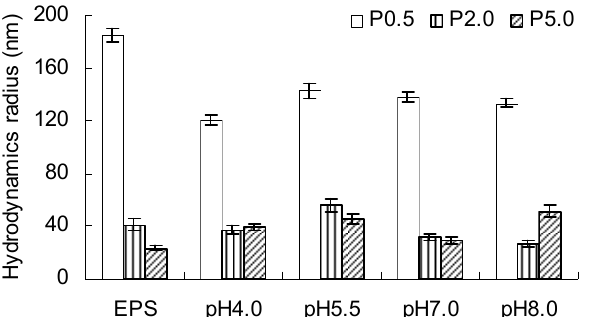
Figure 3. Hydrodynamic radius of EPS fractions (P 0.5 , P 2.0 , P 5.0 ) and EPS-AgNP complexes (P 0.5 -AgNPs, P 2.0 -AgNPs, P 5.0 -AgNPs) at different pH. (AgNP formation did not occur at pH = 4 for EPS fractions P 0.5 and P 2.0 ).